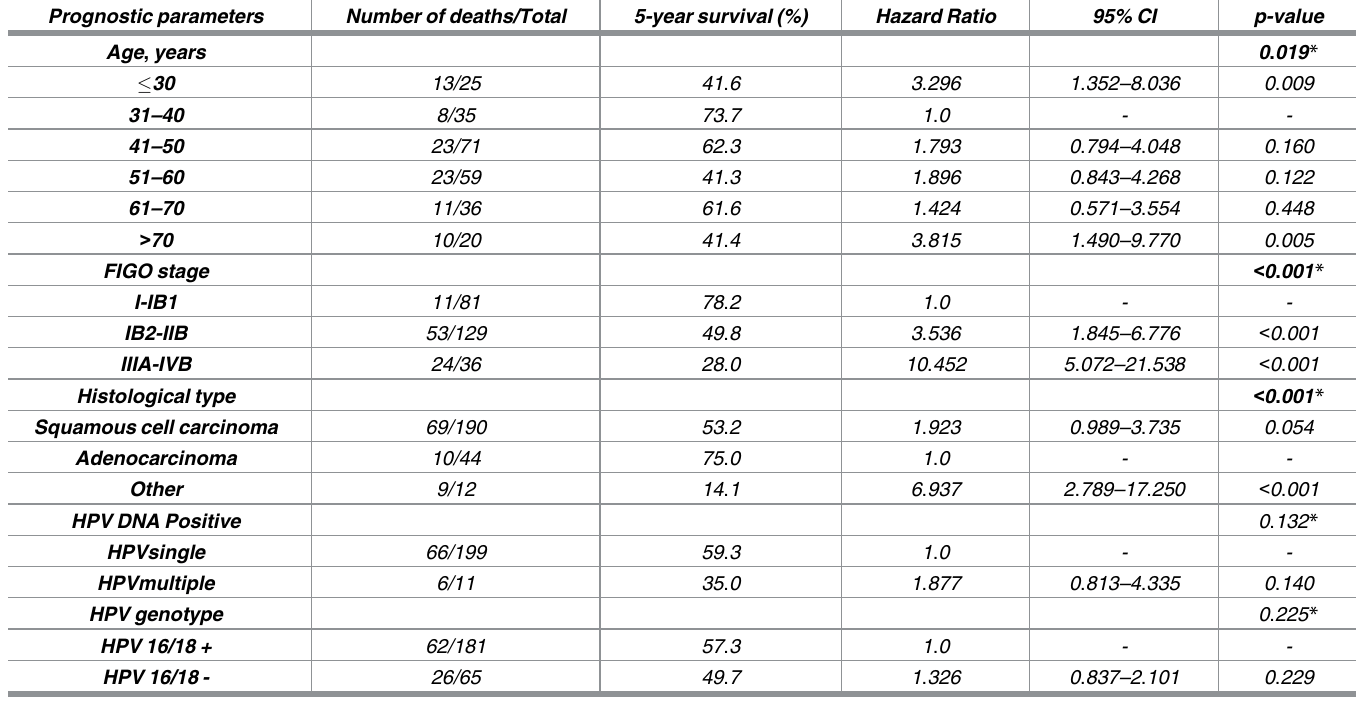
Table 3. Five-yearsurvival rate according to clinical, histopathological and HPVgenotype variables.